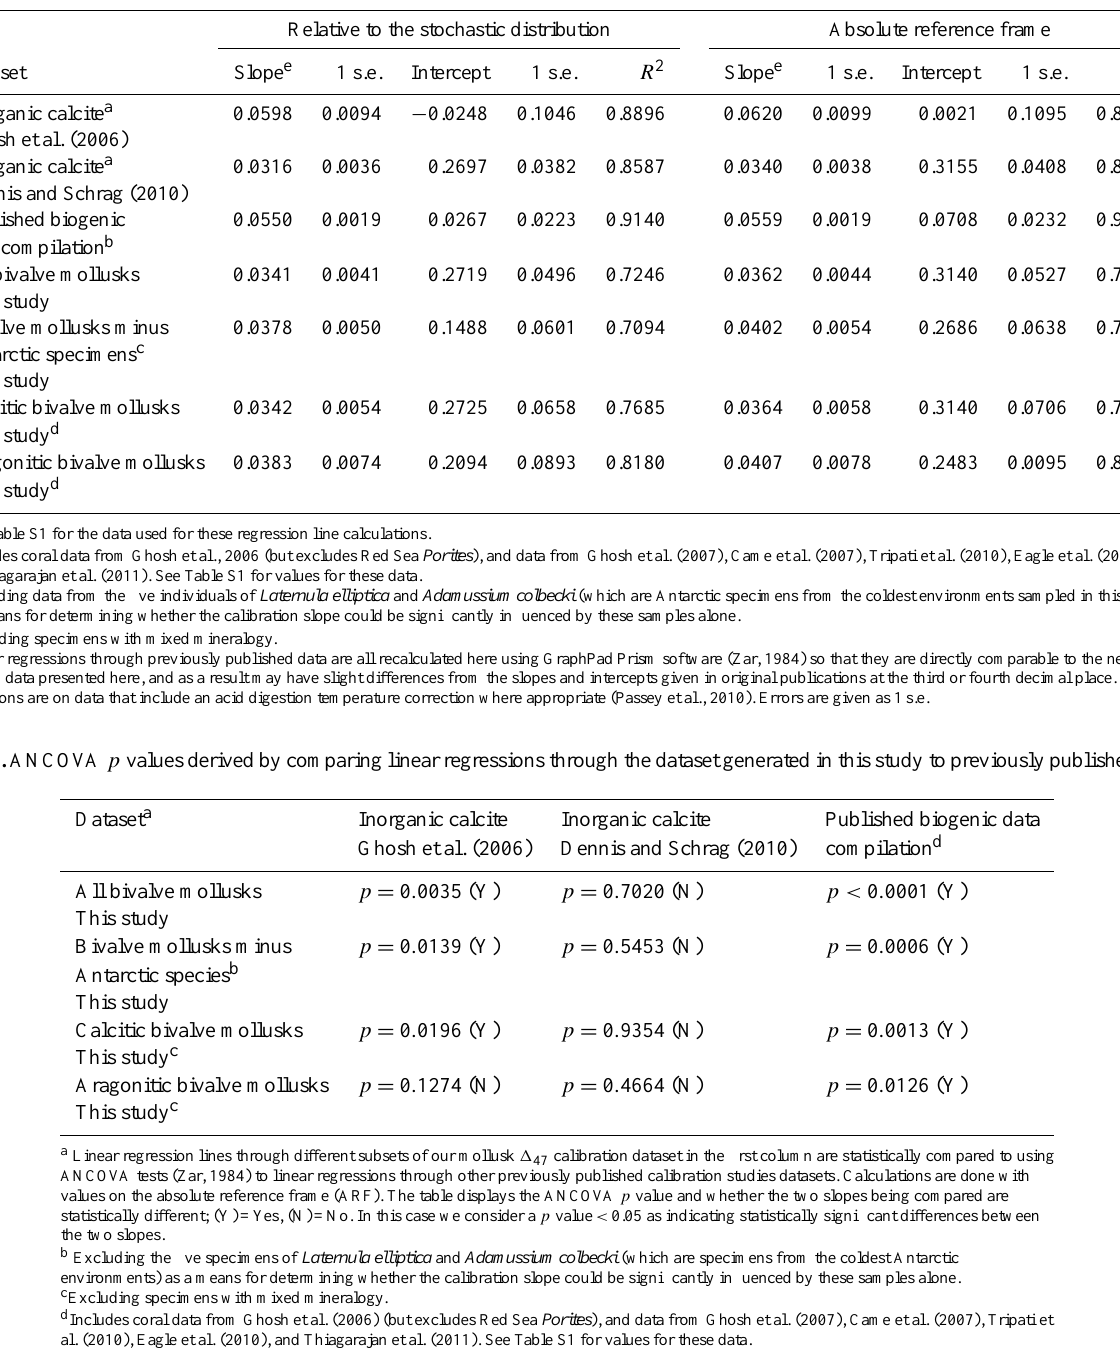
Table 4. Slopes and intercepts of linear regressions through 1 47 and temperature data for samples with known growth